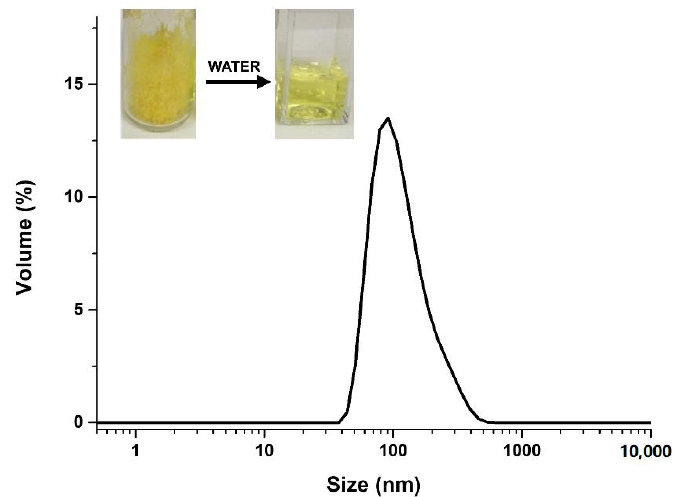
Figure 7. Volume-weighted hydrodynamic diameter distribution of the SC4OC6/CUR/TMZ (0.85 mM/0.11 mM/0.5 mM) ternary assembly and pictures of the lyophilized powder re-suspended by water addition.